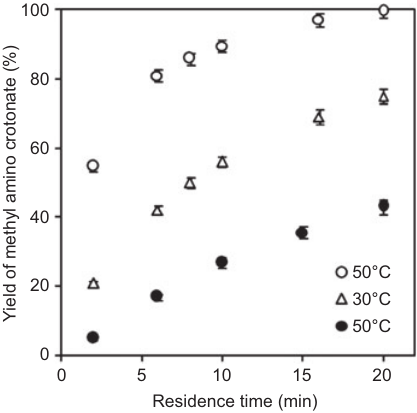
Figure 3 Effect of temperature on the variation in the % yield of methyl amino crotonate with residence time in a continuous fl ow = 1:2. Open symbols indicate the continu- reactor with MAA:NH 3 ous fl ow experiments (samples collected at the outlet for specifi c residence time in the tubular reactor) and closed symbols correspond to the data from batch experiments (sample data at different time